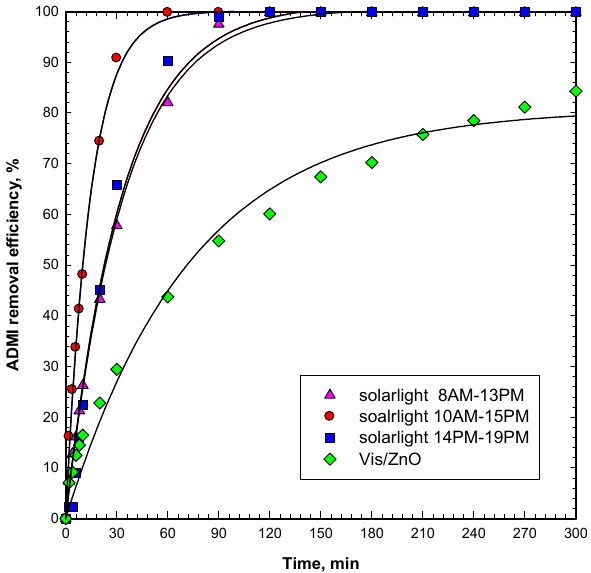
Figure 10. The comparisons of OG degradation (in ADMI removal efficiency) for various visible light sources by the Vis/ZnO process. The operating conditions were: initial OG concentration of 50 mg L − 1 , ZnO dosage of 60 g m − 2 , and reaction time duration of 300 min.